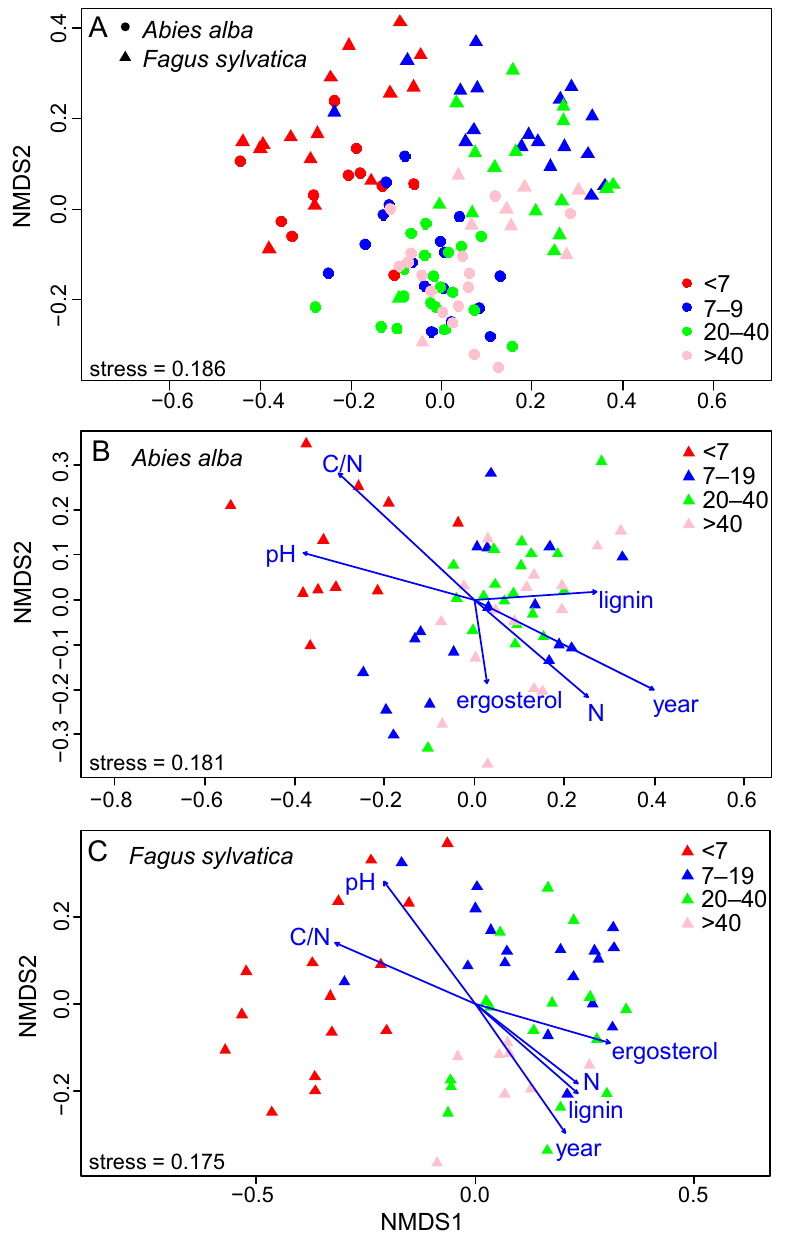
Figure 3. Two-dimensional NMDS of fungal communities in the coarse woody debris (CWD) of Abies alba and Fagus sylvatica from the Salajka natural forest. All CWD ( A ), CWD of A. alba ( B ) and CWD of F. sylvatica ( C ) with fitted environmental vectors. The vectors indicate the significant environmental variables.